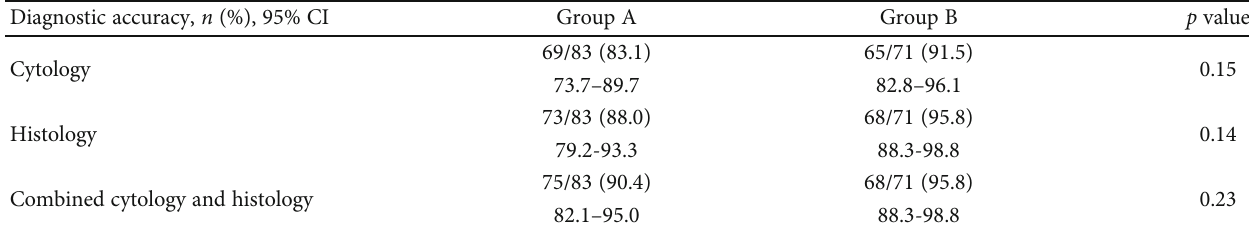
Table 8: Diagnostic accuracy comparisons between the conventional (Group A) and Franseen (Group B) needle groups regarding cytology, histology, and combined cytology and